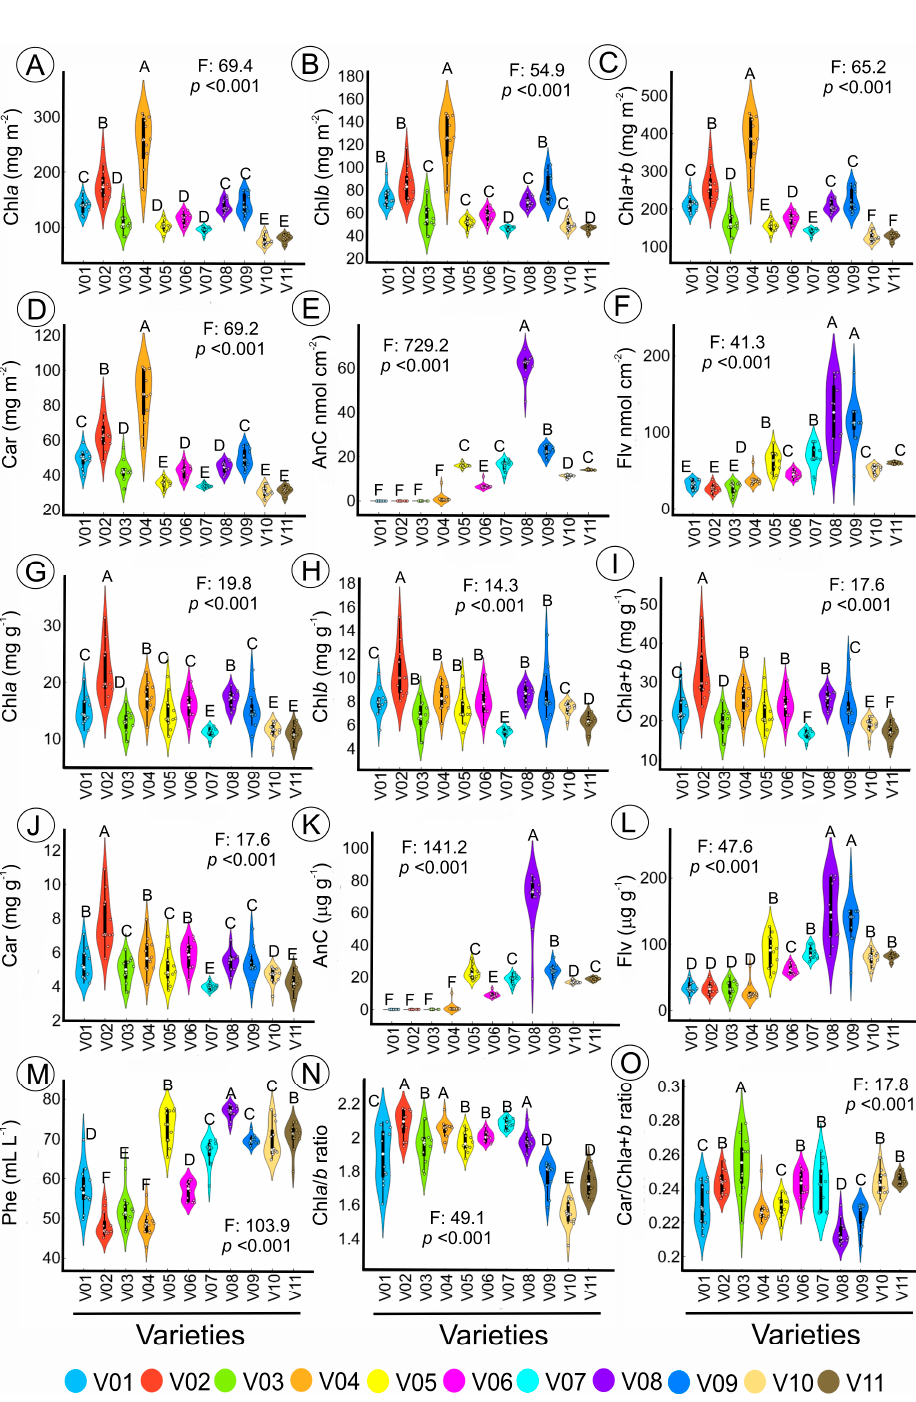
Figure 2. Violin plot of leaf pigment concentration expressed by ( A – F ) leaf area (mg m − 2 ), ( G – L ) mass (mg g − 1 ), ( M ) volume (mL L − 1 ) and ( N,O ) ratio units. Different letters over the violin plot indicate significant differences by Duncan’s test ( p < 0.001) between lettuce plants. Abbreviation in Section 4 ( n =